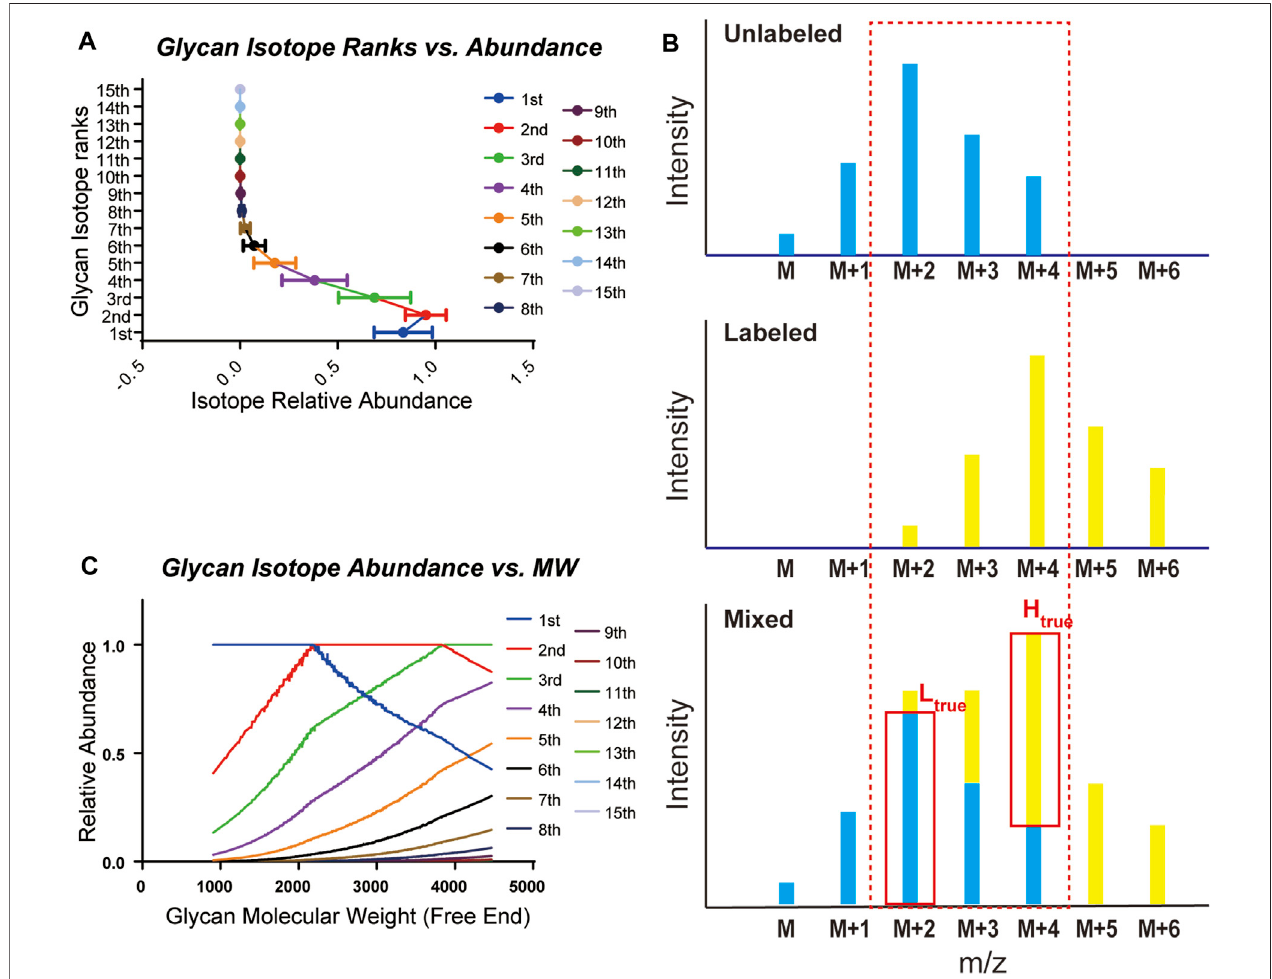
FIGURE 2 | Statistical analysis of glycan isotopic patterns used in gQuant. (A) Theoretical relative abundance of all 15 isotopes in the mammalian glycan database (maximum isotope abundance in each glycan was set as 1.0). (B) Ratio calibration considering isotope co-interference in quantitation. (C) Distribution of theoretical relative intensity of glycan